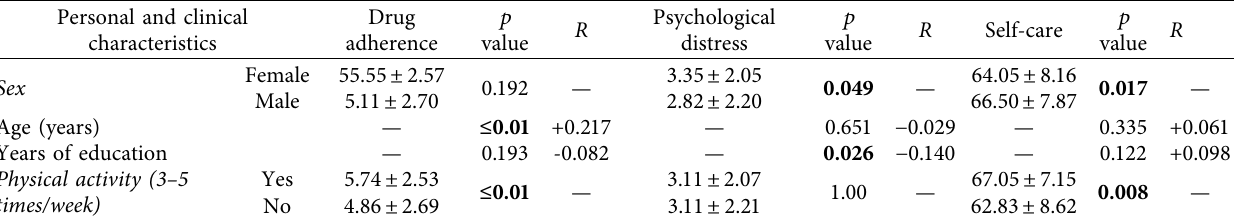
Table 4: Comparison of the scores of drug adherence, psychological distress, and self-care with age, sex, years of education, and regular daily physical activity. A p value < 0.05 was considered